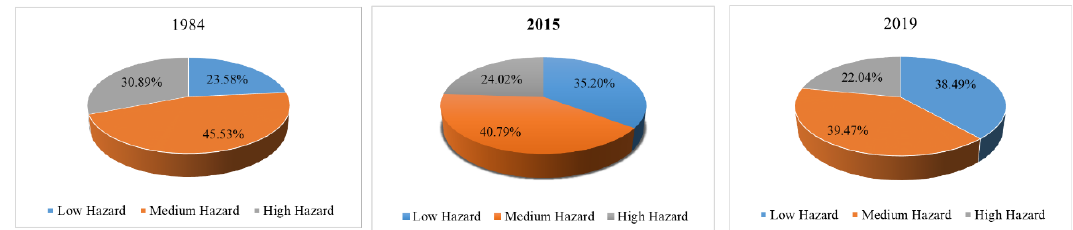
Figure 11. Inundation maps showing the hazard levels affecting the urban areas ( a ) and estimates of the vulnerable areas for flood hazard categories ( b ) over time from 1984 to 2019 in Ras Gharib.